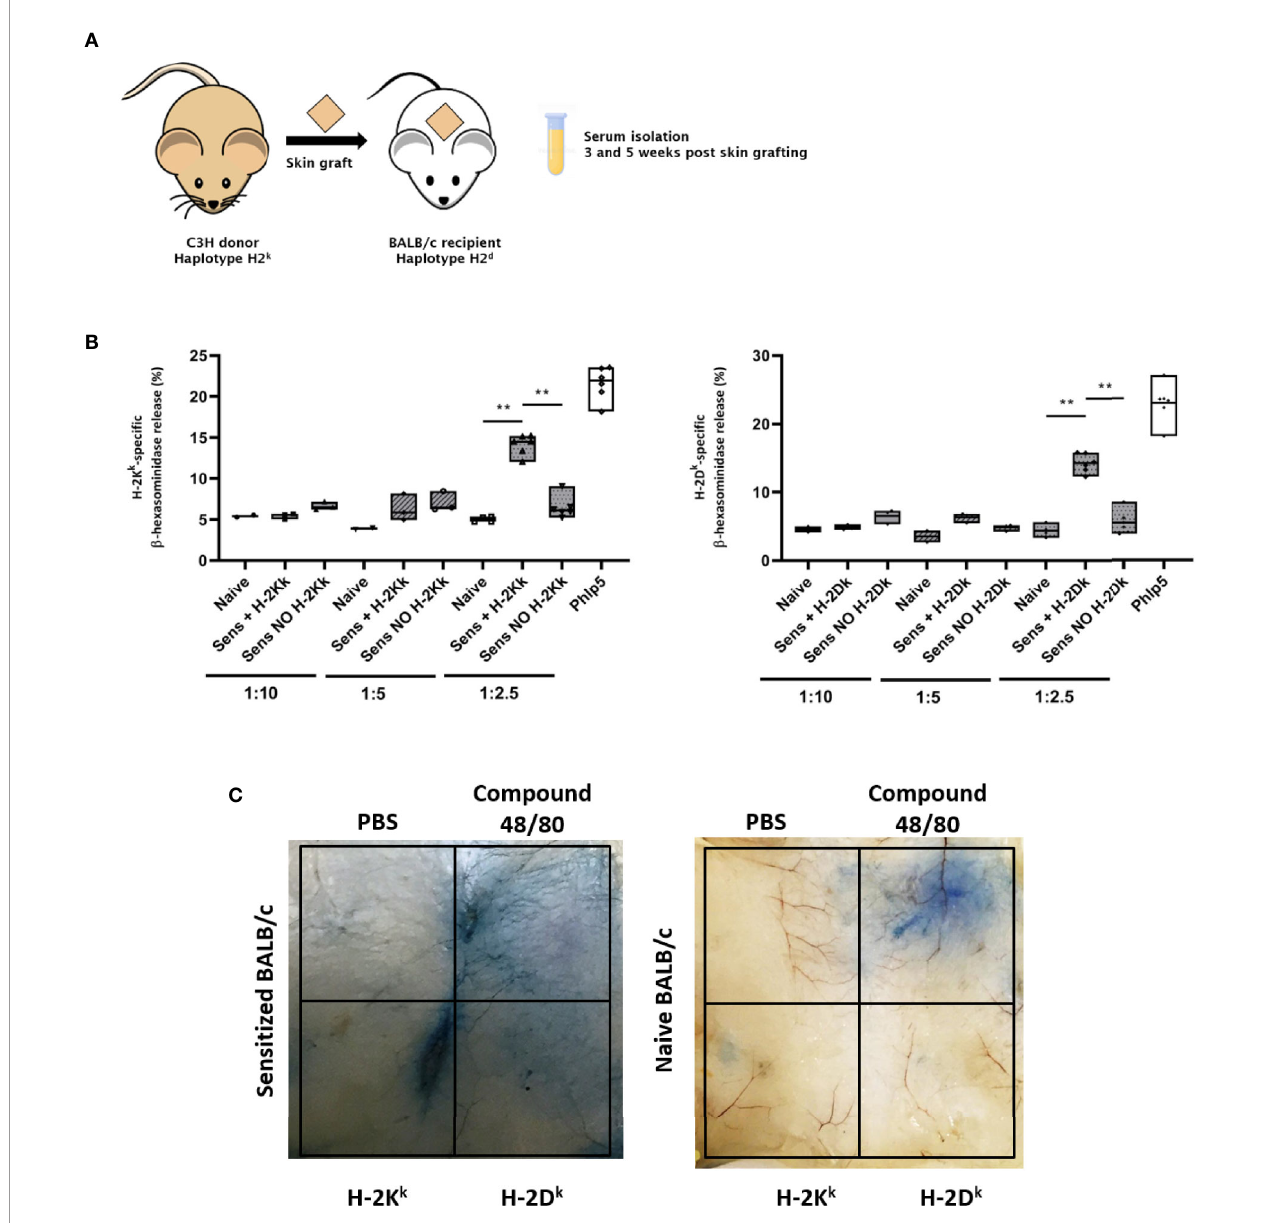
FIGURE 7 | Testing of the functional activity of MHC speci fi c IgE in vitro and in vivo . (A) Schematic illustration of the experimental set up. Skin of C3H donor mice was grafted onto BALB/c recipient mice. Serum was isolated 3 and 5 weeks after transplantation. (B) RBL assay for testing the functional activity of MHC-speci fi c IgE in vitro . RBL cells were incubated with naïve and sensitized BALB/c serum, after rejection of a C3H skin graft (haplotype k), with or without the MHC class I monomer H-2K k or H-2D k . Serum was diluted either 1:10, 1:5 or 1:2.5 with medium. Serum dilutions 1:10 and 1:5 were tested in one experiment (n=3). The experiment was repeated once with serum diluted 1:2.5 (n=6). P values were calculated with Mann-Whitney U test. **P< 0.01. (C) Assessment of functional activity of MHC-speci fi c IgE in vivo using the cutaneous type I hypersensitivity assay. Evans Blue (0.5%) was injected i.v. into sensitized (with C3H skin) or naive BALB/c mice followed by an intra-dermal injection of MHC monomers. Mice were sacri fi ced and their skin was inverted. A blue discoloration of the inverted skin indicates mast cell degranulation due to the presence of MHC-speci fi c IgE. This Figure shows a representative photo [see also